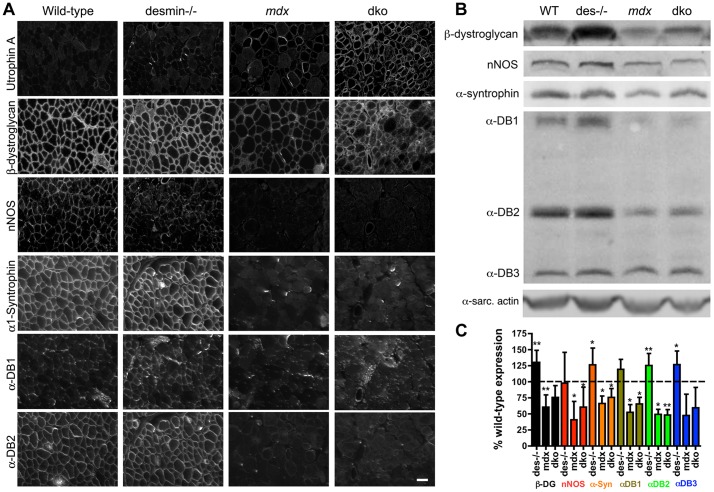
Localization and expression of β-dystroglycan and the NODS complex in skeletal muscles.
A) Adjacent sections of gastrocnemius muscles showing the localization of β-dystroglycan and the NODS complex at the sarcolemma of wild-type, desmin-/-, mdx4cv and dko skeletal muscles. Scale bar  = 50 µm. B) Western analysis of quadriceps muscles reveals an increase in expression of DGC proteins in the desmin-/- and a reduction in the mdx4cv and dko muscles. α-DB is α-dystrobrevin and α-sarc. actin is the α-sarcomeric actin loading control. C) Bars show mean +/− S.D. densitometric quantitation of protein expression graphed as a percentage of wild-type. *P<0.05, **P<0.01 compared to wild-type. N = 4–8 for all experiments.